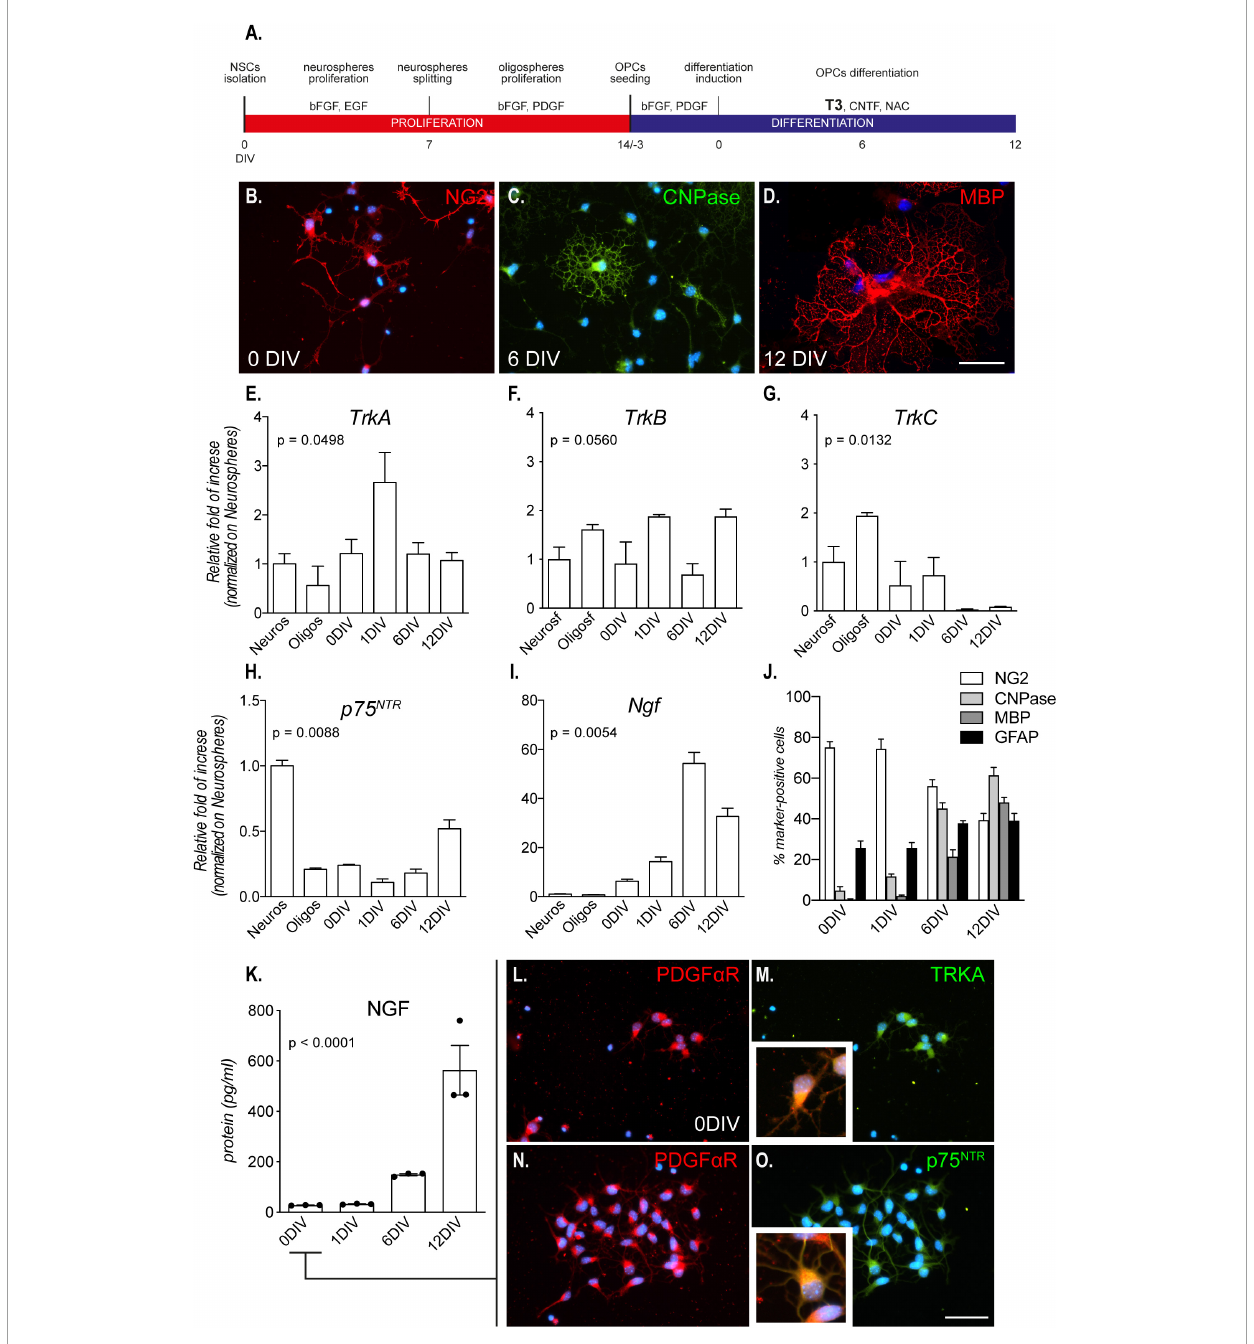
FIGURE1 Culture characterization. (A) Mixed OPC/astrocyte cultures were obtained from NSC isolation and neurosphere expansion (bFGF and EGF). Following oligosphere generation by spheroid splitting and bFGF/PDGF exposure, spheres were dissociated, and single cell cultures seeded in the same medium. After 3 DIVs, the medium was replaced with differentiation medium containing T3 for 12 DIVs. (B–D) Representative images of culture progress from OPCs (NG2-positive cells, 0 DIV, panel B ), through mature OLs (CNPase-positive cells, 6 DIV, C) to mature/myelinating OLs (CNPase/MBP-positive cells, 12 DIV, panel D ). Scale bar: 20 µ m. (E–I) Graphs show relative mRNA expression of TrkA (E) , TrkB (F) , TrkC (G) , p75 NTR (H) , and Ngf (I) genes, throughout all culture stages and normalized on neurospheres; n = 3 replicates for all the presented groups. (J) Graph shows the culture composition along the differentiation phase (DIV 0 – 12), expressed as percentage of cells positive to NG2 (OPCs), CNPase (pre-OL), MBP (mature OLs), and GFAP (astrocytes). (K) Graph shows absolute NGF protein quantification (pg/ml) at all differentiation stages, from 0 DIV (OPCs/astrocytes) to 12 DIVs (mature OLs/astrocytes); n = 3 replicates for all the presented groups. (L–O) Representative images of OPCs (PDGF α R-positive cells, panel L and panel N ) double positive for TRKA (M) and p75 NTR (O) , prior to the differentiation induction mediated by T3 (0 DIV). Scale bar: 20 µ m. Bars represent mean + SEM. Statistical analysis: Kruskal-Wallis test, p -values are reported inside the graphs. Single dots in the graph represent single protein quantifications from independent samples (K) . CNPase, 2 (cid:48) ,3 (cid:48) -cyclic nucleotide 3 (cid:48) -phosphodiesterase; bFGF, basic fibroblast growth factor; DIV, day in vitro ; EGF, epidermal growth factor; MBP, myelin basic protein; NG2, chondroitin sulfate proteoglycan, neural/glial antigen 2; NGF, nerve growth factor; p75 NTR , low affinity nerve growth factor receptor; PDGF, platelet derived growth factor; PDGF α R, platelet derived growth factor alpha receptor; T3, triiodothyronine; TrkA, Tropomyosin receptor kinase A, TrkB: Tropomyosin receptor kinase B, TrkC: Tropomyosin receptor kinase